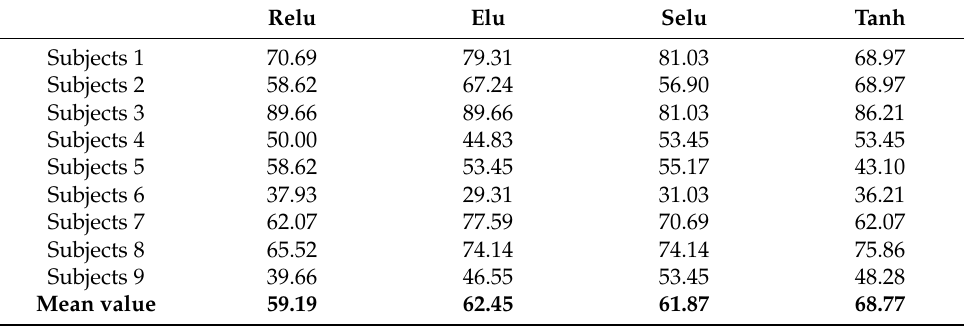
Table 3. Classification accuracy of the proposed CNN1 methods (%).